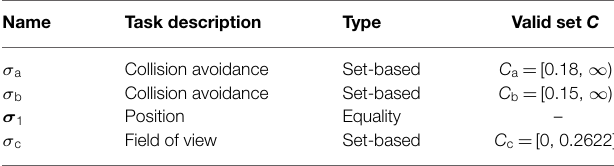
TABLE 5 | Implemented tasks in example 1 sorted by decreasing priority